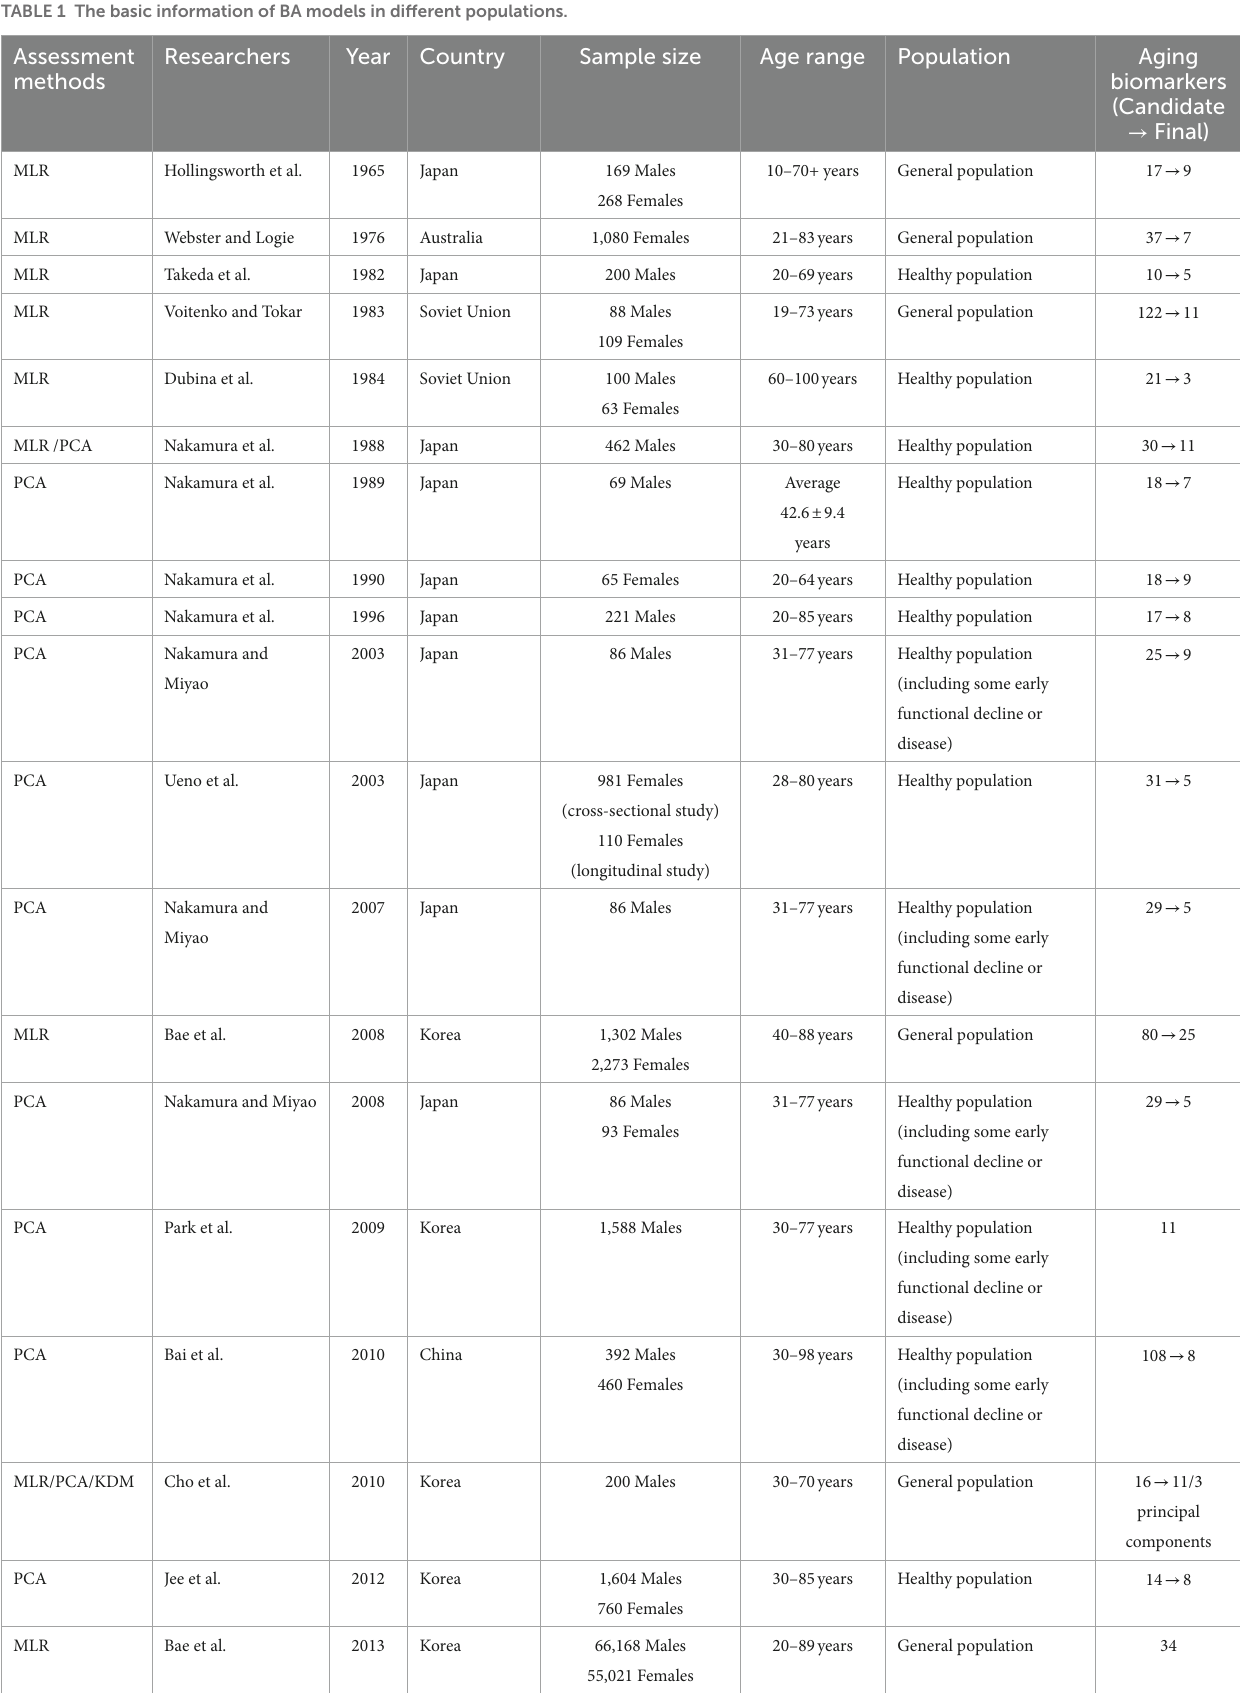
TABLE 1 The basic information of BA models in different populations. Assessment